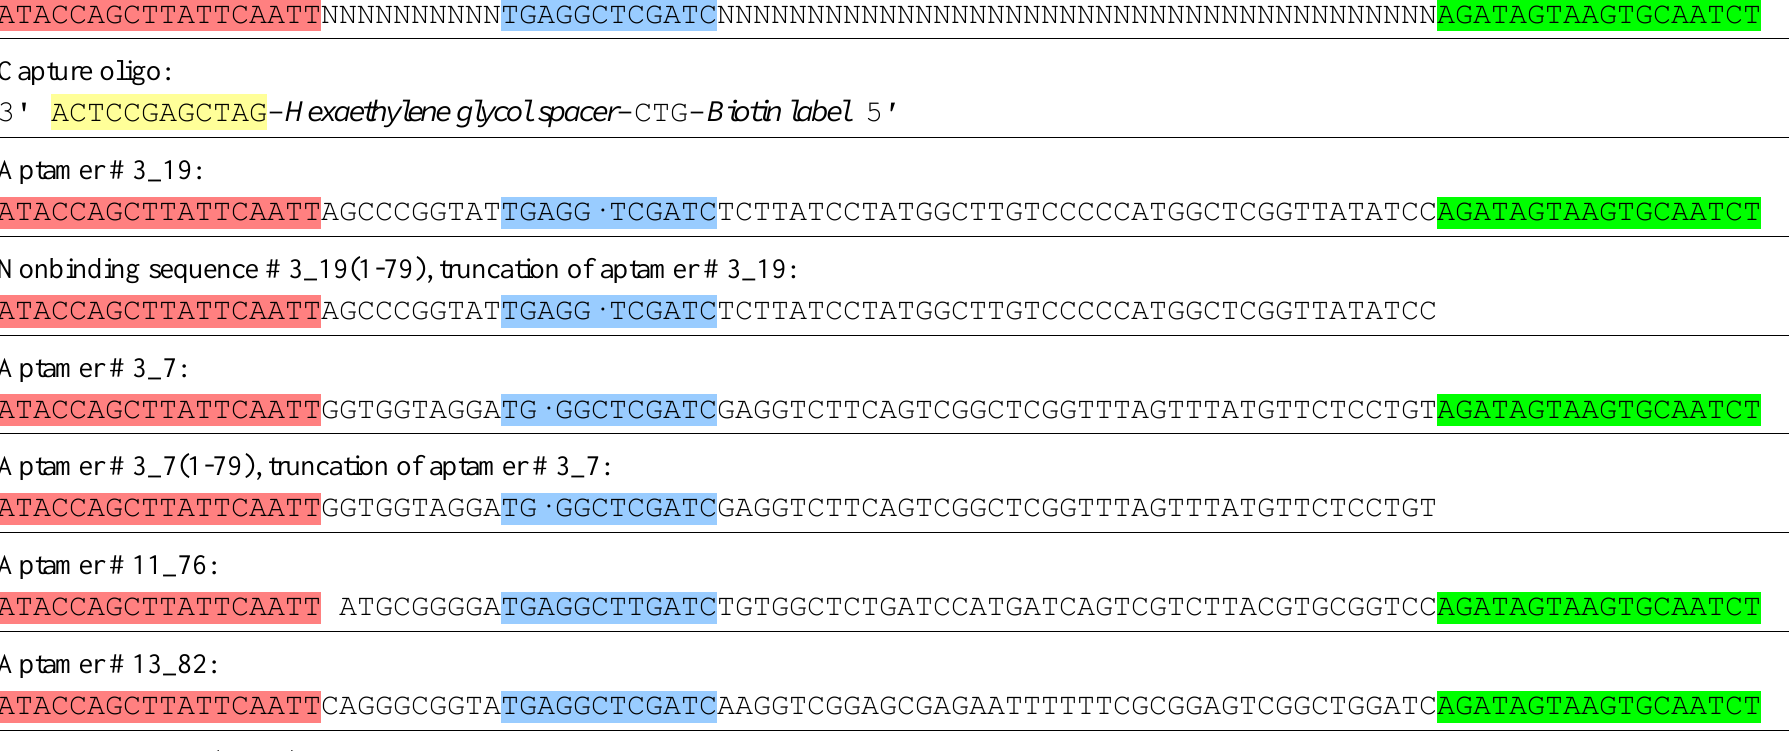
Table 1. Sequences of the oligonucleotides in the random library, of the capture oligo, aptamers for kanamycin A, derived from Capture-SELEX [12], and truncations thereof. The 5' and 3' primer binding sites are highlighted in red and green, respectively. The docking sequence is highlighted in blue and its complementary part in the capture oligo is highlighted in yellow. Deletions in the sequence compared to the starting random library are denoted as a dot. Direction is 5'→3' if not stated otherwise. Oligonucleotides in the random library